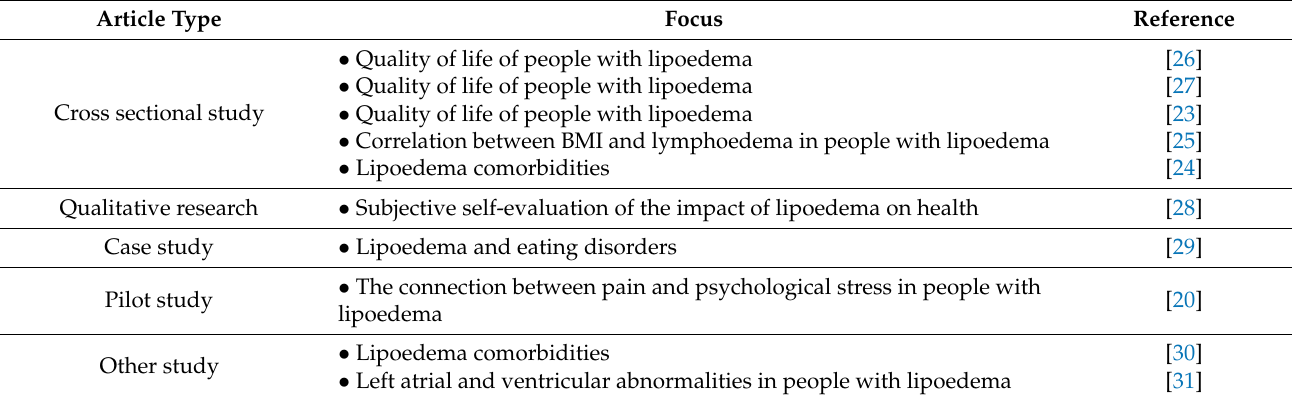
Table 1. Description of articles initially included by PRISMA methodology.